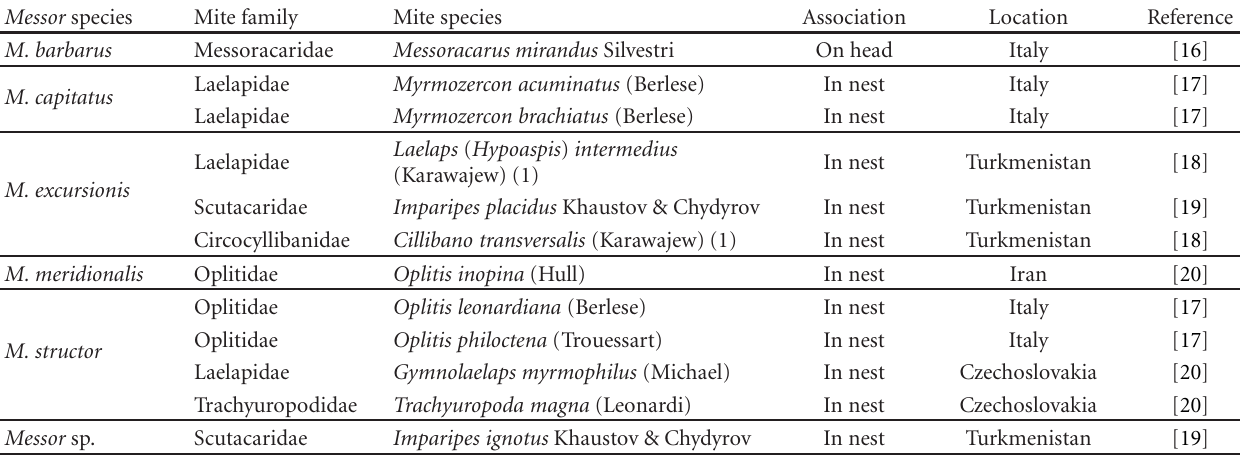
Table 1: A list of mite species associated with ants of the genus Messor . Generic names follow current taxonomic standing. Messor species